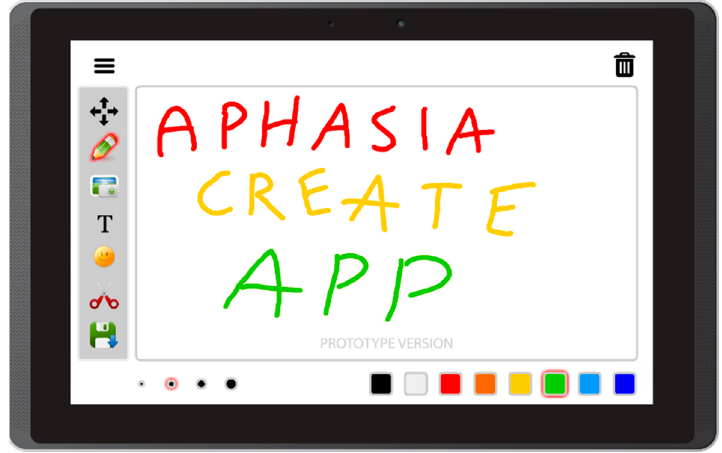
Figure 3. Free drawing and taking quick notes tools in Aphasia Create (screenshot from an Android tablet).